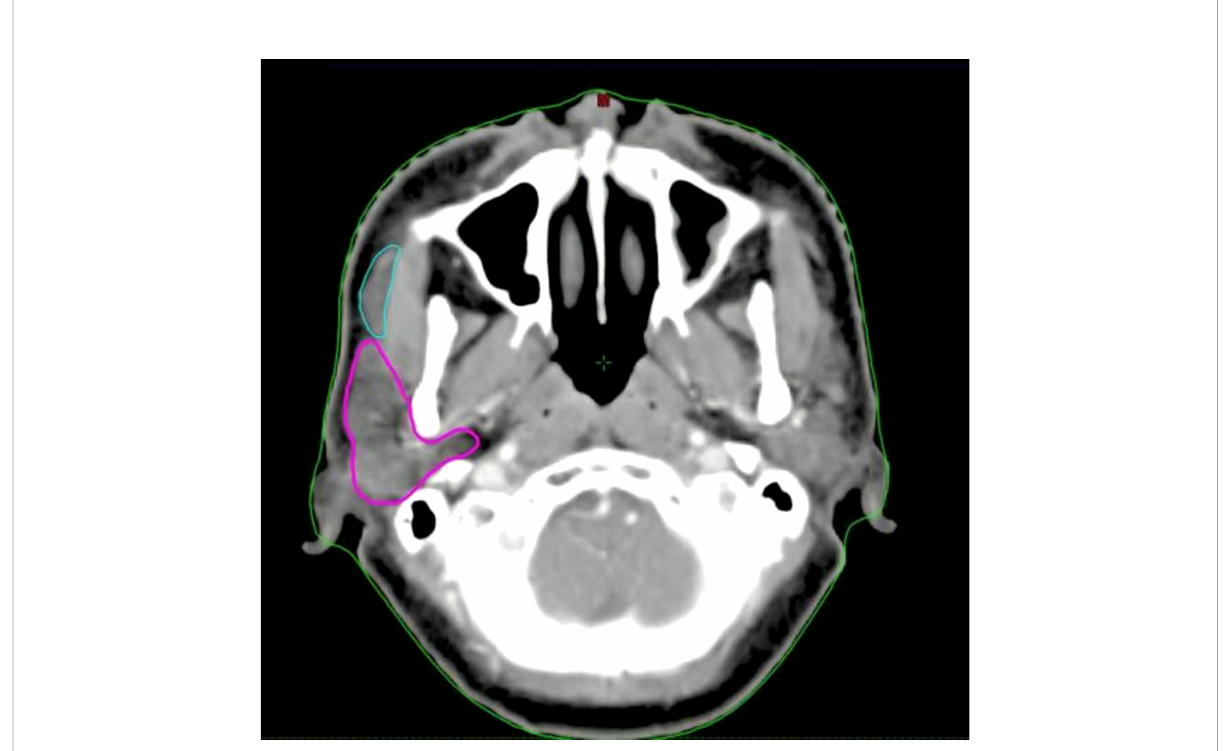
FIGURE 1 Delineation of the parotid glands (purple) and accessory parotid gland